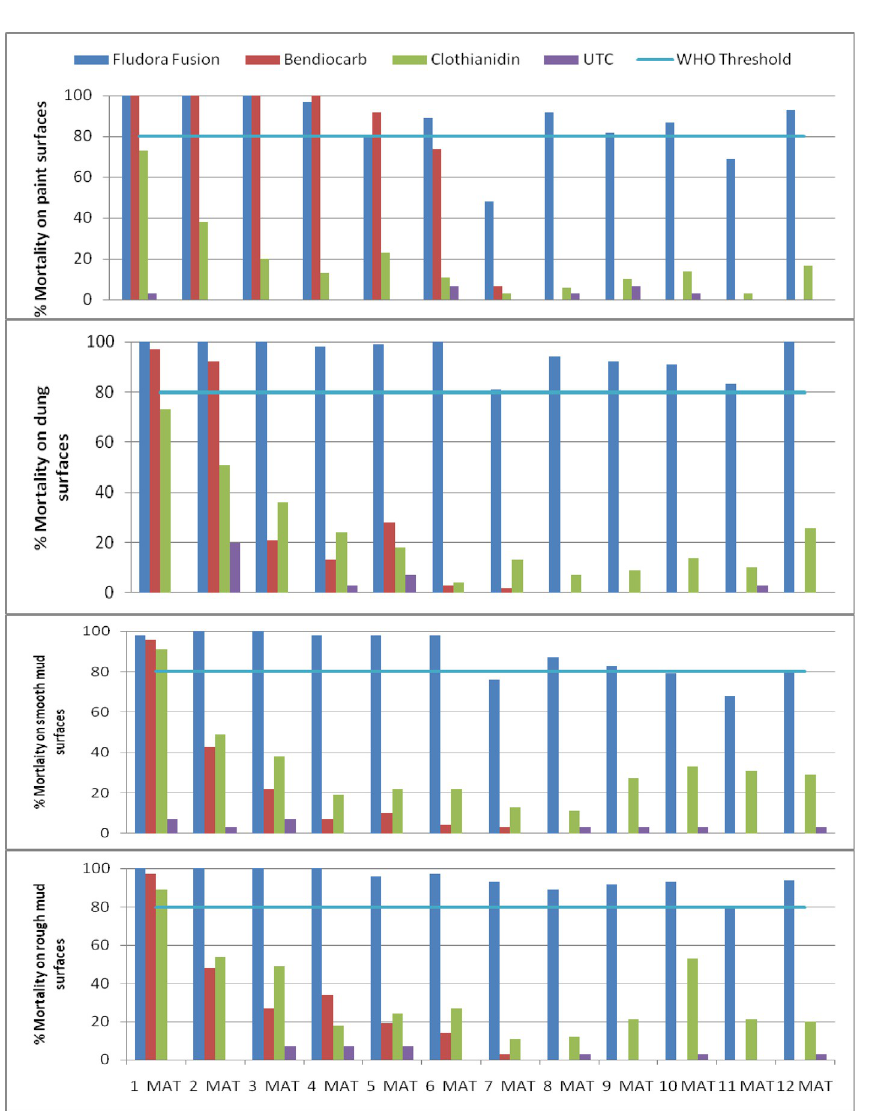
Fig 2. Residual activity of insecticides against susceptible An . arabiensis on four surface types of simple huts wall cone bioassays at 24 hours holding time post-exposure, Ethiopia.